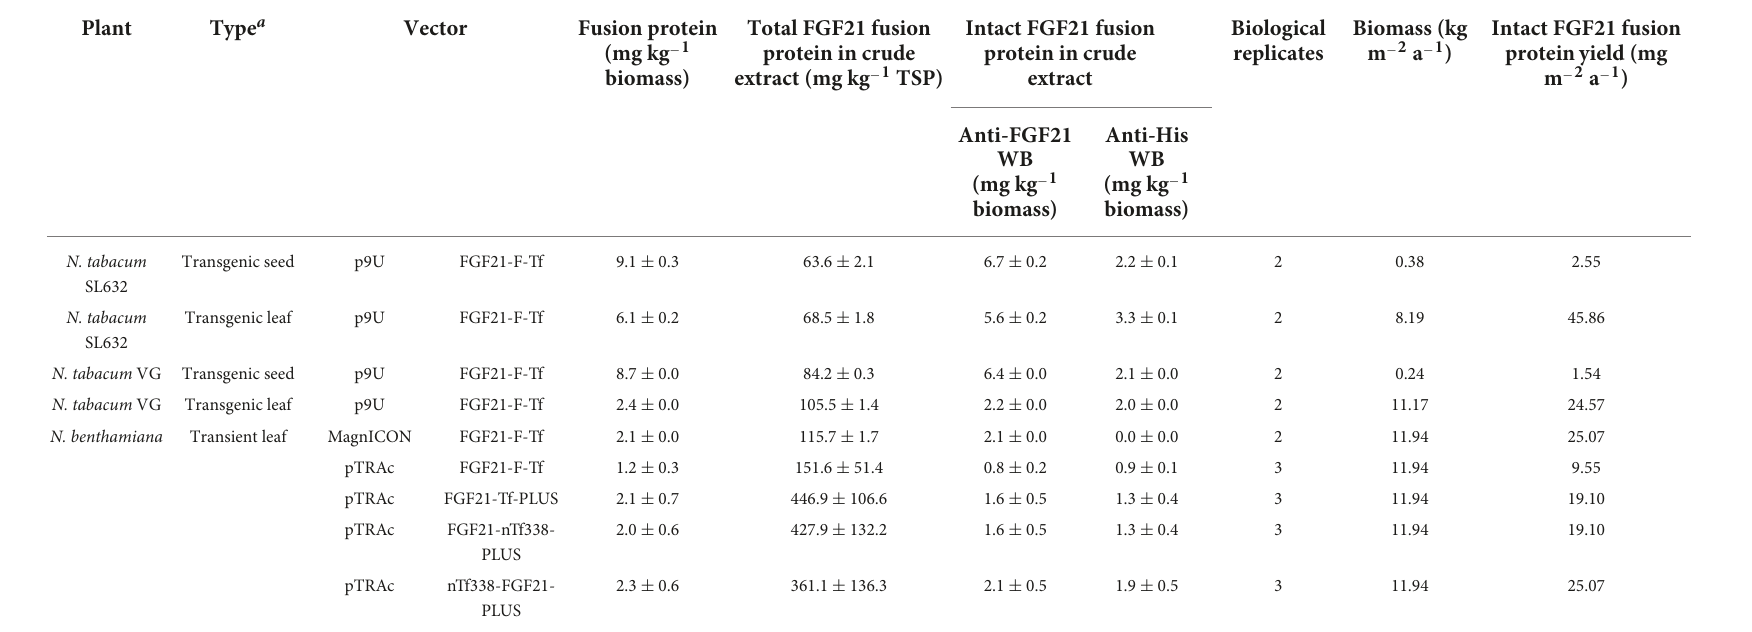
Numbers represent mean ± SD. Total FGF21 fusion protein was determined by the FGF21 ELISA and intact FGF21 fusion protein was obtained by correcting ELISA data by anti-FGF21 and anti-His Western blot analysis and estimation of the relative amountofintactfusionproteinandcleavedFGF21.Biomassreferstoleaffreshmass(LFM)orseeddrymass(SDM),whichwerecalculatedwiththehelpofthedatashownin Table2 . a NumberfortransgenicplantsrefertoseedsoftheT1generationand